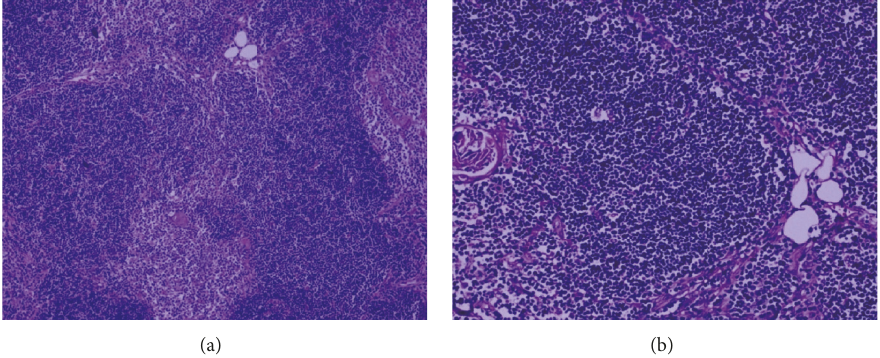
Figure 2: Microscopic images of thymic hyperplasia: great lymphoid follicles ((a) hematoxylin and eosin stain (H&E), magnification × 100), Hassall’s corpuscles, and the rarity of adipose tissue ((b) hematoxylin and eosin stain (H&E), magnification × 200).